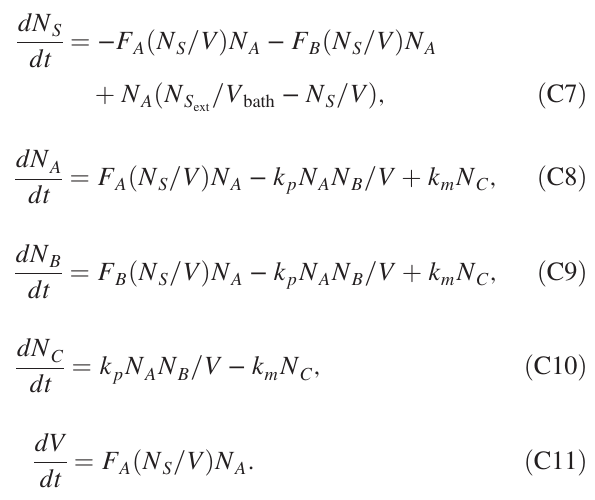
Stoichiometry of glucose and amino acids (measured by carbon, average) Stoichiometry of amino acids and average proteins Stoichiometry of amino acids and ribosomal